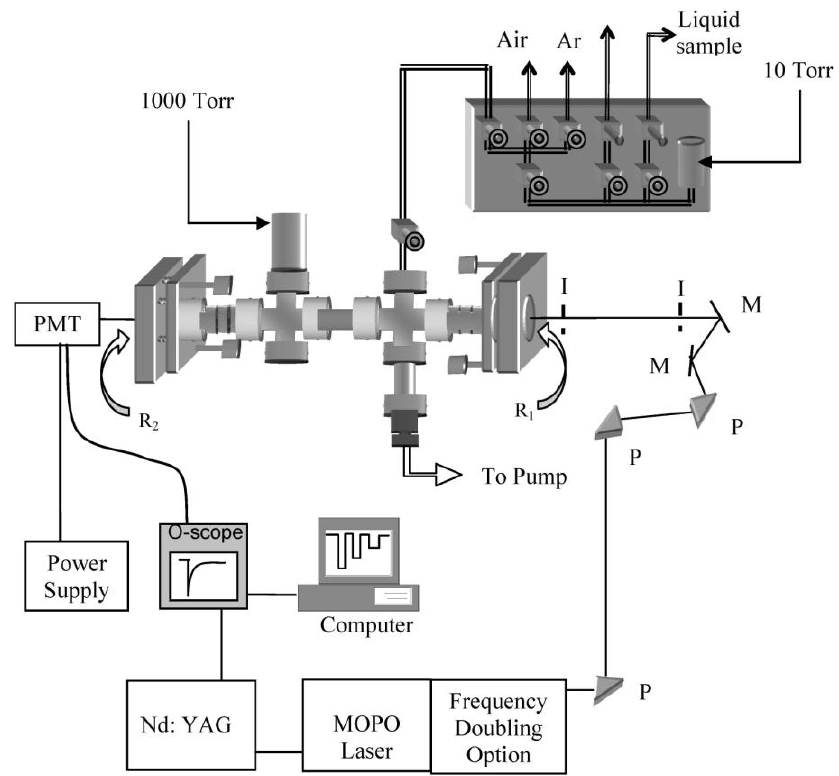
Figure 2. Schematic of the experimental system. This experiment utilized an MOPO-HF-FDO laser system to generate UV laser light, which was injected into a ringdown cavity that was housed in a stainless steel vacuum chamber. An in-house sample introduction system was constructed and utilized. R = ringdown mirror, I = irises, P = UV prism, M = beam steering